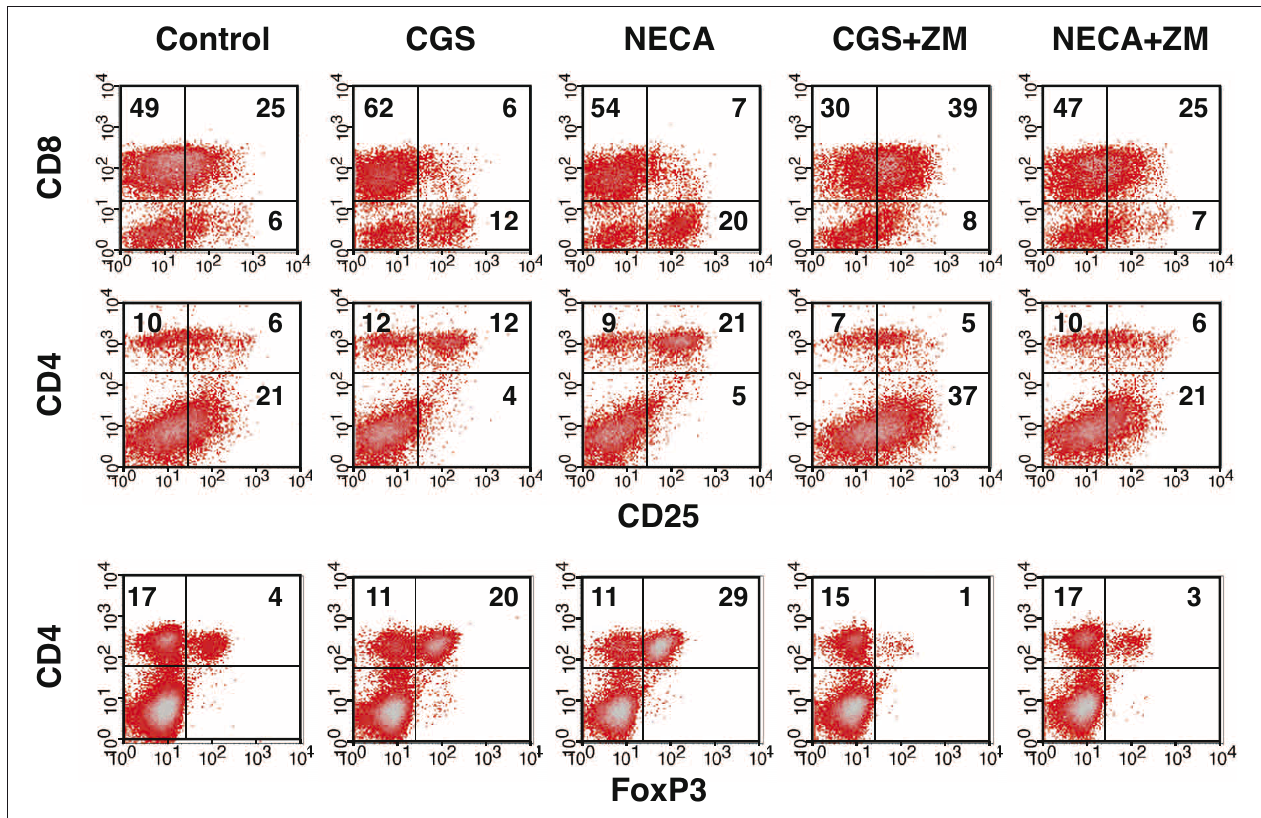
increased in the same culture (middle row). The change in CD4 + CD25 + cells correlated well with an increase of FoxP3-expressing CD4 + cells (bottom row). The addition of A2AR antagonist ZM241385 (1 μ M) reversed the changes. Numbers in the panels represent percentages in each quadrant. The data shown here represent four separate experiments with similar